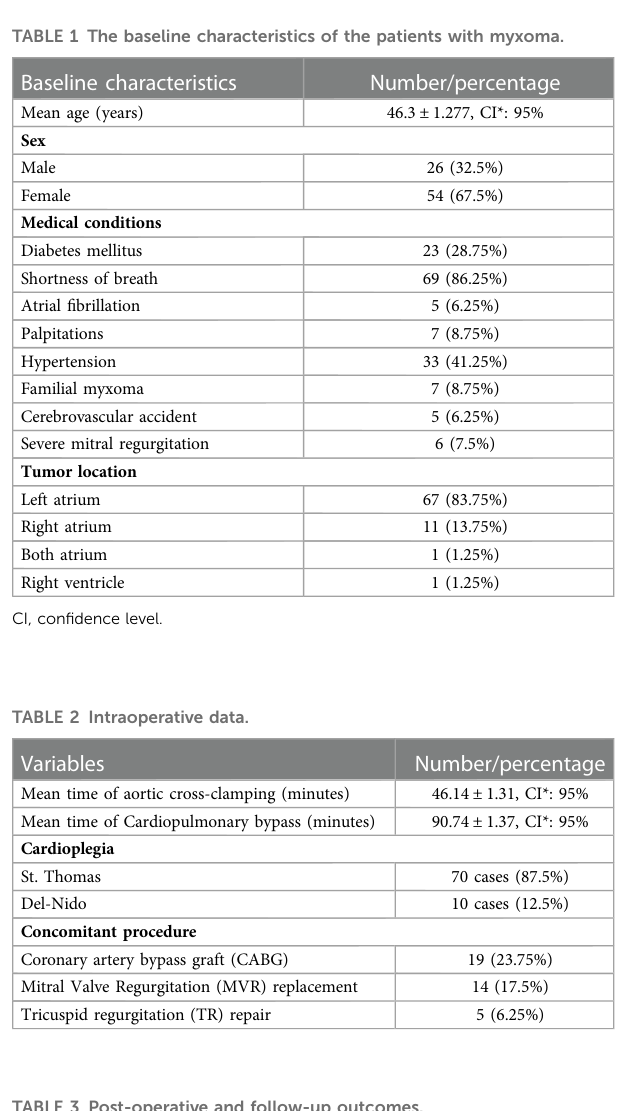
TABLE 3 Post-operative and follow-up outcomes.